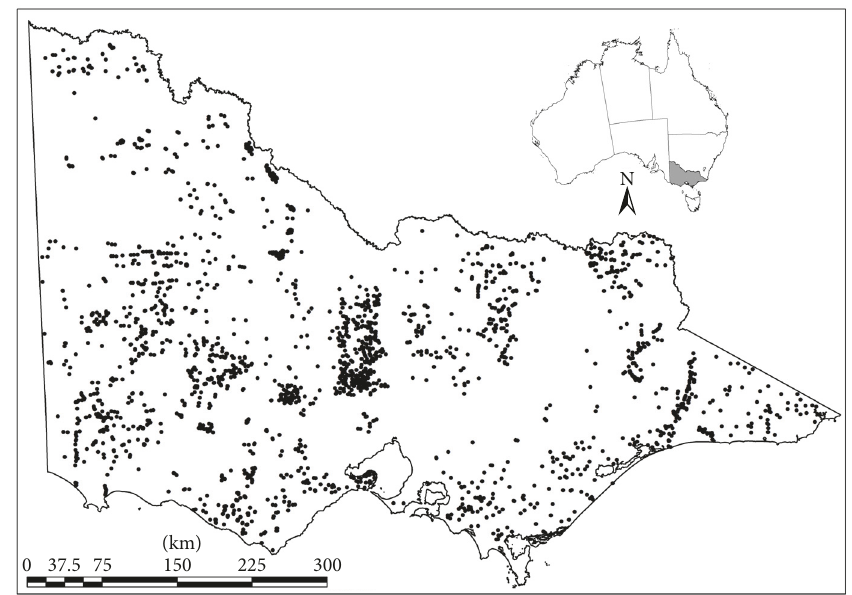
Figure 1: Locations for soil pH measurements in Victoria using a soil pH indicator test kit.